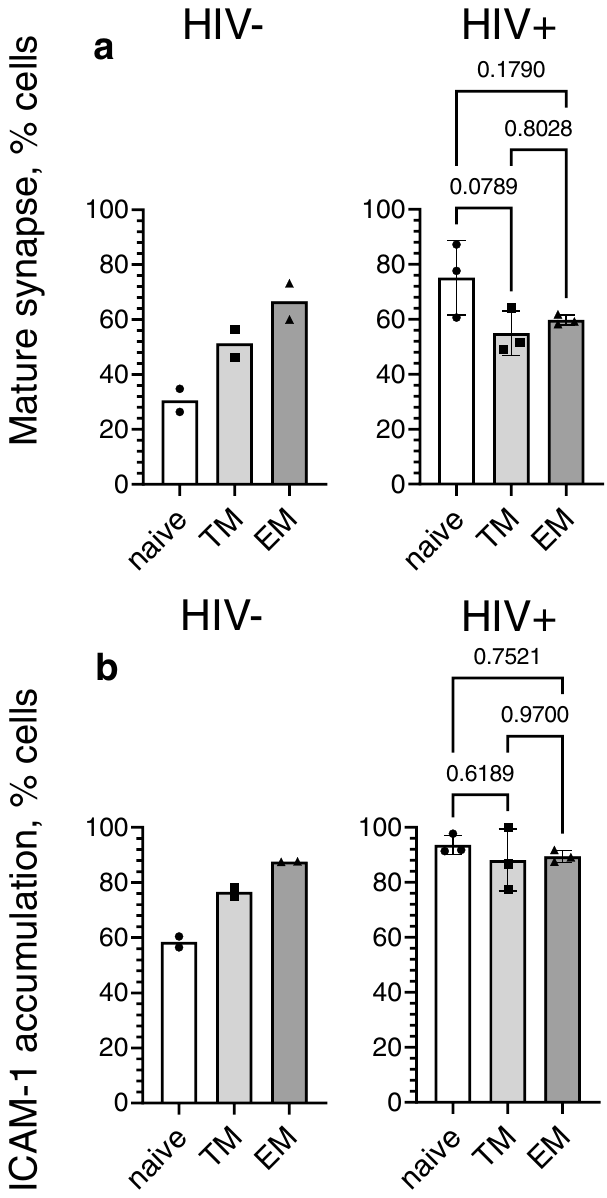
Fig. 5 | Naive CD8 T cells from untreated HIV+ individuals exhibit greater capacity to accumulate ICAM-1 and form mature synapse compared to T cells from HIV- individuals. Naive, transitional and effector memory CD8 T cells were exposed to bilayers containing anti-CD3 antibodies and ICAM-1, and formation of mature synapses was observed at 30min. Frequency of naive, transitional and effector memory T cells establishing mature synapse ( a ) and accumulating ICAM-1 molecules at interface ( b ) are shown. Infection status of individuals are indicated. Two independent experiments were done for HIV − donor group, and data are expressed as average values. Three independent experiments were done for HIV+ subject group and presented as mean with SDs. Each dot point indicate indepen- dent experiment. Statistical difference was analyzed by ordinary one-way ANOVA with Tukey multiply comparison test; p values are indicated on the graph (HIV+ donor group). Source data are provided as a source data fi